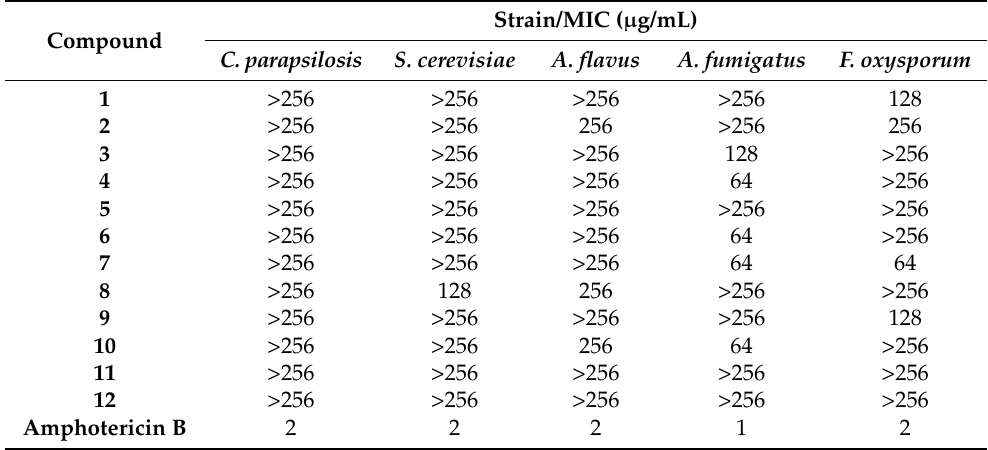
Table 4. Assessment of antifungal activities of coumarin–thiadiazole hybrids 1-12 expressed as MIC values against C. parapsilosis , S. cerevisiae , A. fumigatus , F. oxysporum